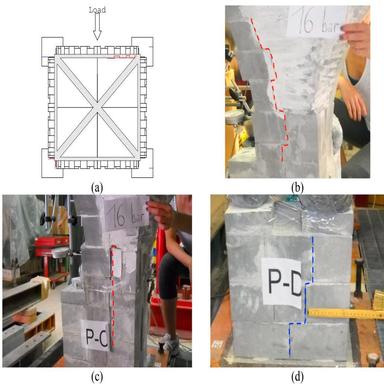
Crack locations: intrados crack (red); through-thickness crack (blue); (b), (c) and (d) crack details. (For interpretation of the references to colour in this figure legend, the reader is referred to the web version of this article.)